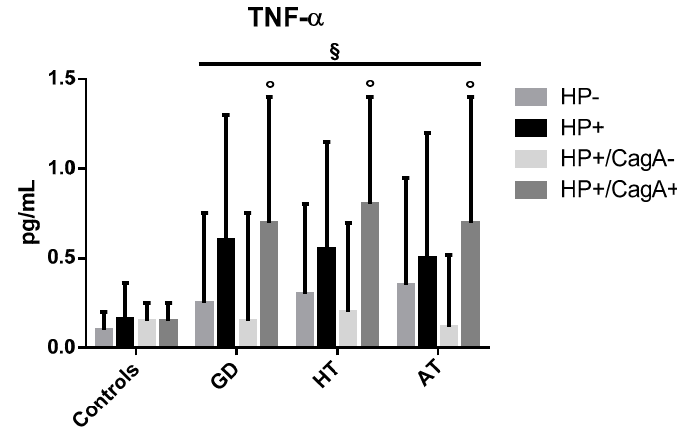
Figure 4. Median values (IQR) of TNF- α in patients and controls according to the overall H. pylori and the CagA infectious status. ° p < 0.05: HP+/CagA+ vs. HP+/CagA − patients, § p < 0.05 AITDs vs. no- AITD.